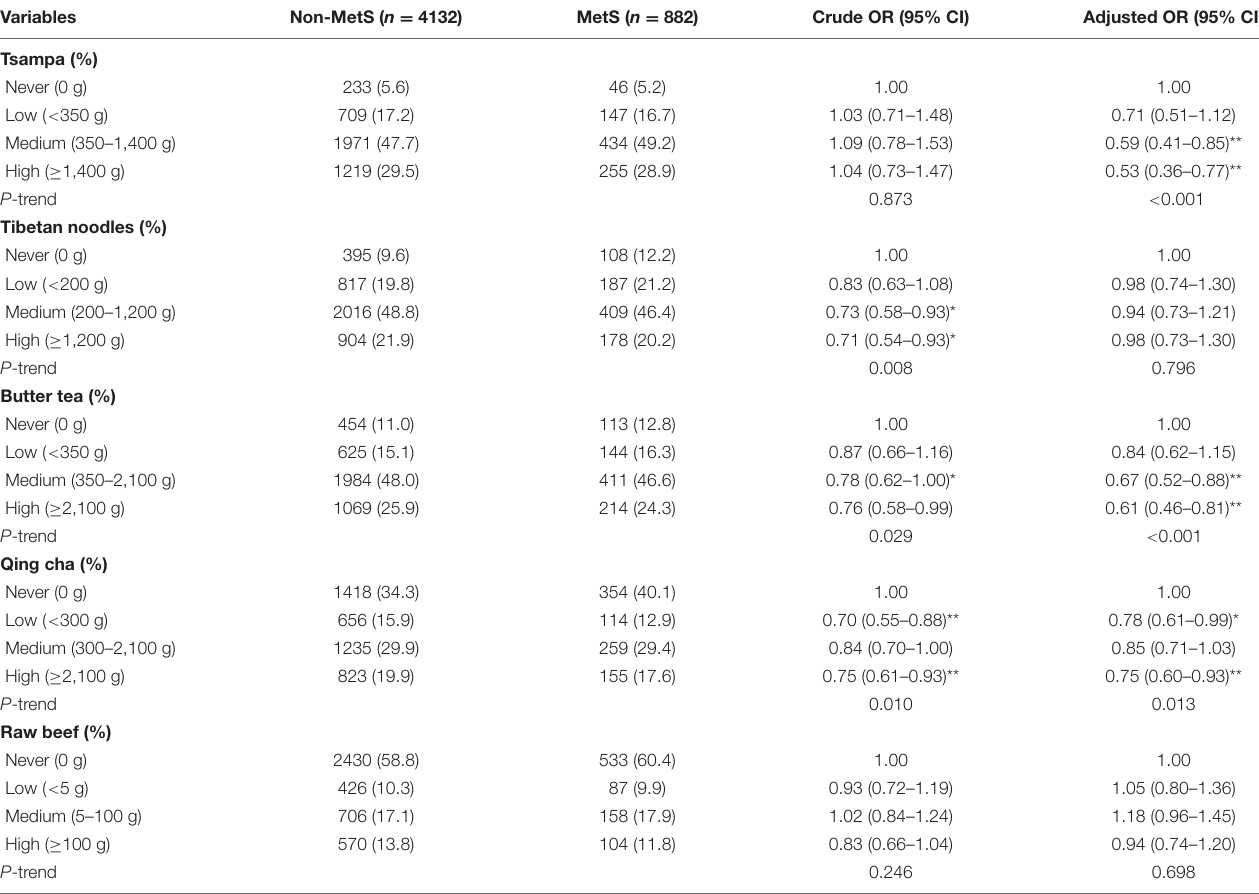
TABLE 2 | The associations between food weekly intake and the prevalence of metabolic syndrome (MetS).